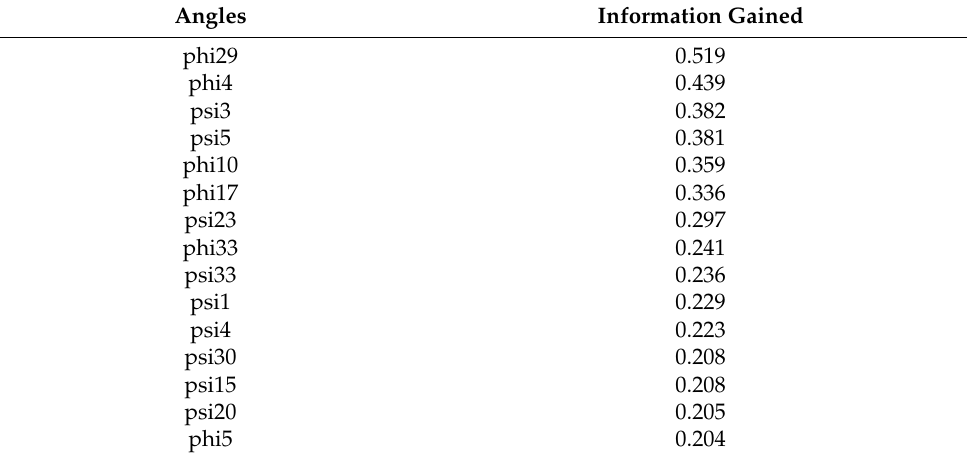
Table 7. Results of Ranking by Results Based on Average Age of